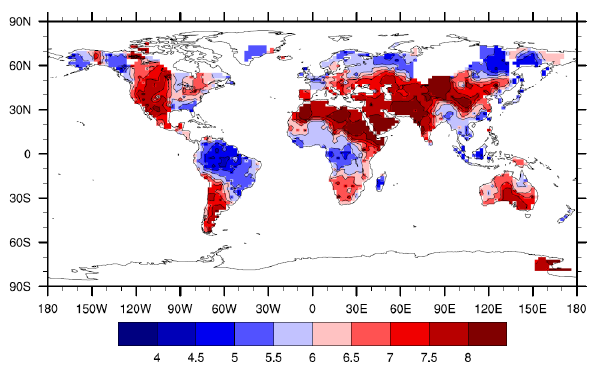
Fig. 5. The global distribution of soil pH. Data Sources: IGBP- DIS (see Tempel et al. (1966) and Pleijsier